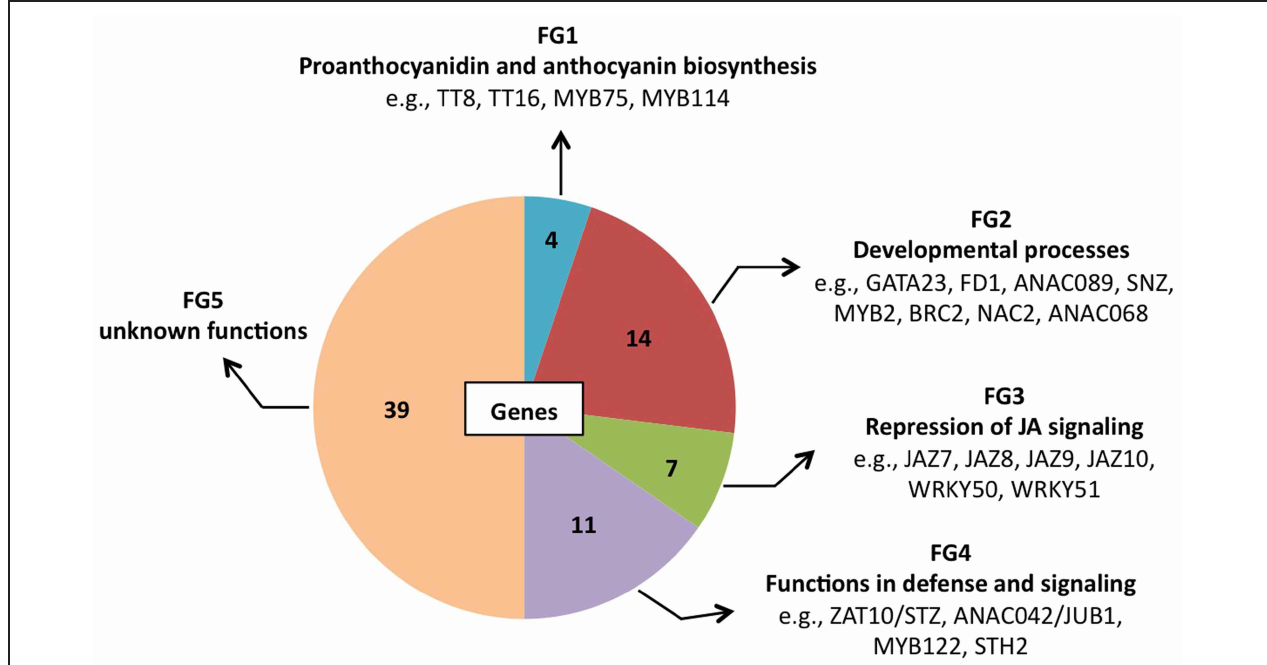
FIGURE 2 | Pie chart representation of the five functional groups (FG) of early H 2 O 2 -responsive TFs in GO plants. FG5 includes genes for which a distinct biological function has not been reported yet.